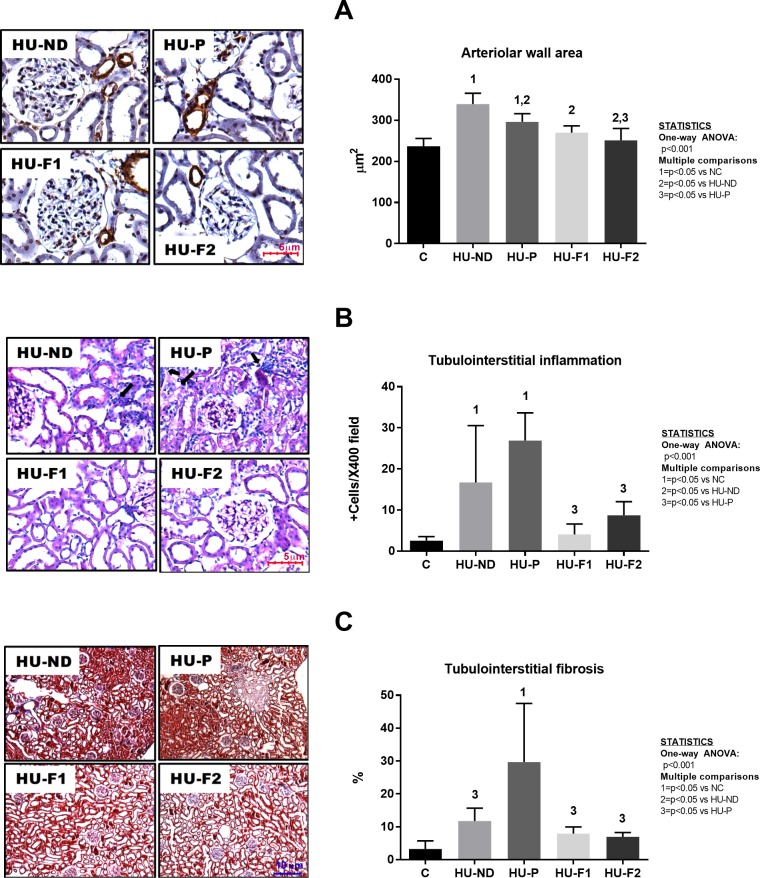
Effect of probiotics-containing diets on renal structural changes induced by hyperuricemia.A) Arteriolar wall area of renal vessels (immunohistochemistry for vascular smooth muscle alpha-actin, 400X) was increased in hyperuricemic groups. Probiotics intake prevented this alteration; this effect was greater observed in the group that received Formula 2. B) Tubulointerstitial inflammation was evaluated with Periodic acid Schiff´s staining, 400X. Hyperuricemia induced inflammatory infiltration that was prevented by probiotics supplementation in the diet. C) Tubulointerstitial fibrosis was evaluated with Masson´s trichromic staining, 100X. Hyperuricemia increased tubulointerstitial collagen deposition; the effect was prevented by probiotics intake. N = 6 each group.